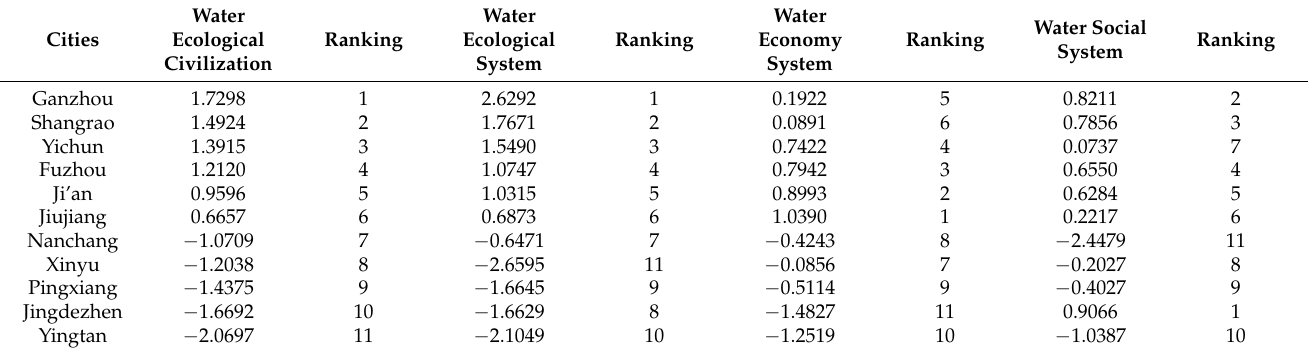
Table 6. Water ecological civilization scores of prefecture-level cities in